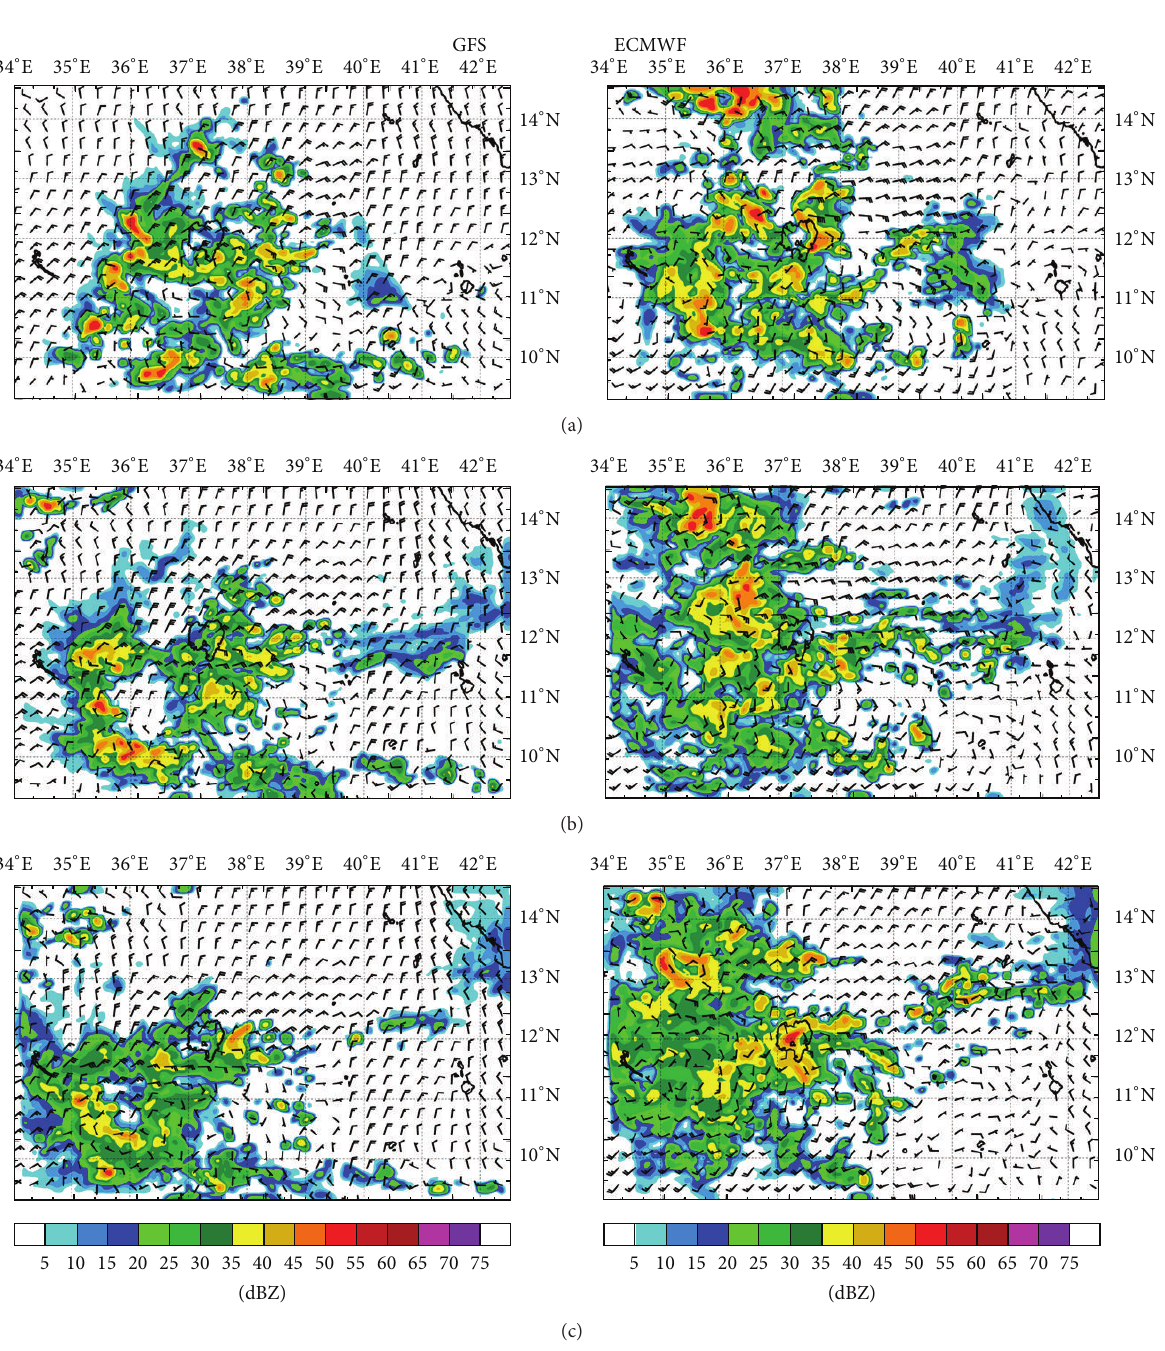
Figure 7: High resolution WRF simulated radar reflectivity and 700 mb wind with GFS initialization (left) and ECMWF (right) for 29 July, 2011: (a) 20:00 LST, (b) 22:00 LST, and (c) 24:00 LST.